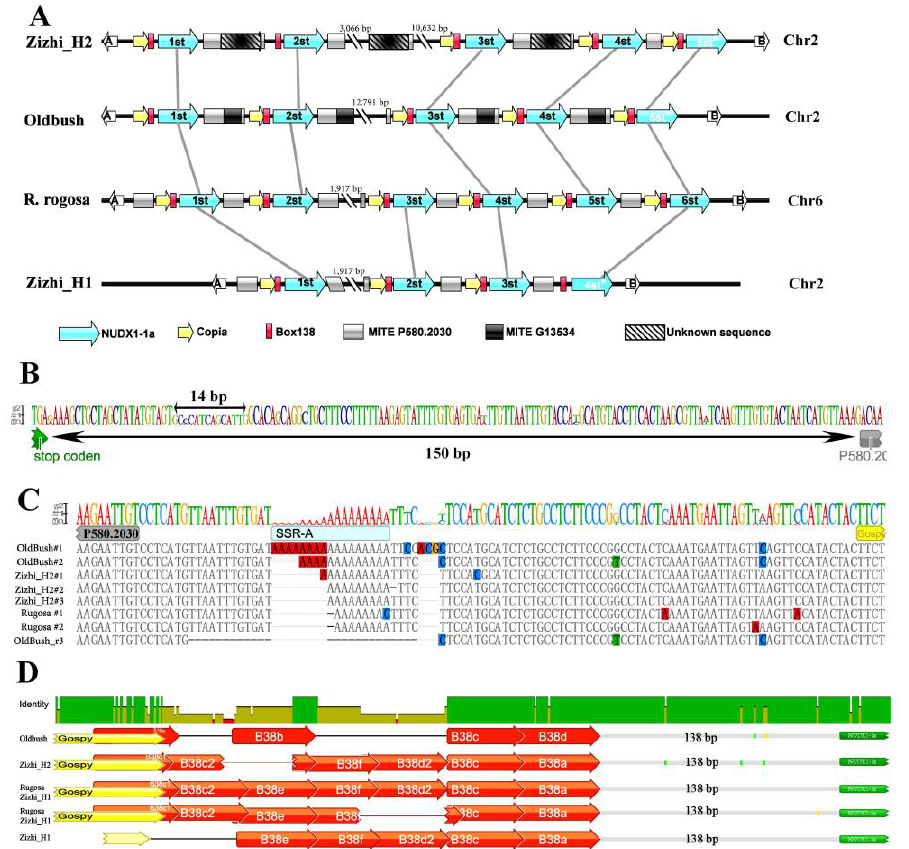
Figure 2. Gene map and micro-synteny of NUDX1-1a clusters and sequence aliments of conserved elements. ( A ) Gene copies and shared elements indicated by 1st–6st were based on the systematic compare of homologous 2st chromosomes of Oldbush. The synteny distances between genes and elements were approximative and long sequences (with on NUDX gene, double dashed) were distorted to show the relative organization. Chr, chromosome. Large blue arrows, NUDX1-1a genes; large yellow arrows, Copia R24588; red boxes, Box38 elements; black boxes, MITE P580.2030; dark boxes, MITE G13554; shadow boxes, function unknown sequences; Blank arrows, marker genes. Chr, chromosomes. ( B ) Aliment of linker regions of stop codon to MITE P580.2030 (only displayed sequence logo). ( C ) Aliment of linker regions of MITE P580.2030 to Copia R24588. Blue box, simple sequence repeat of ‘A’. ( D ) Aliment of linker regions of Copia R24588 to initiation codon of NUDX1-1a. Red arrows, Box38. * indicated the pseudogenes which lack of full coding sequence.